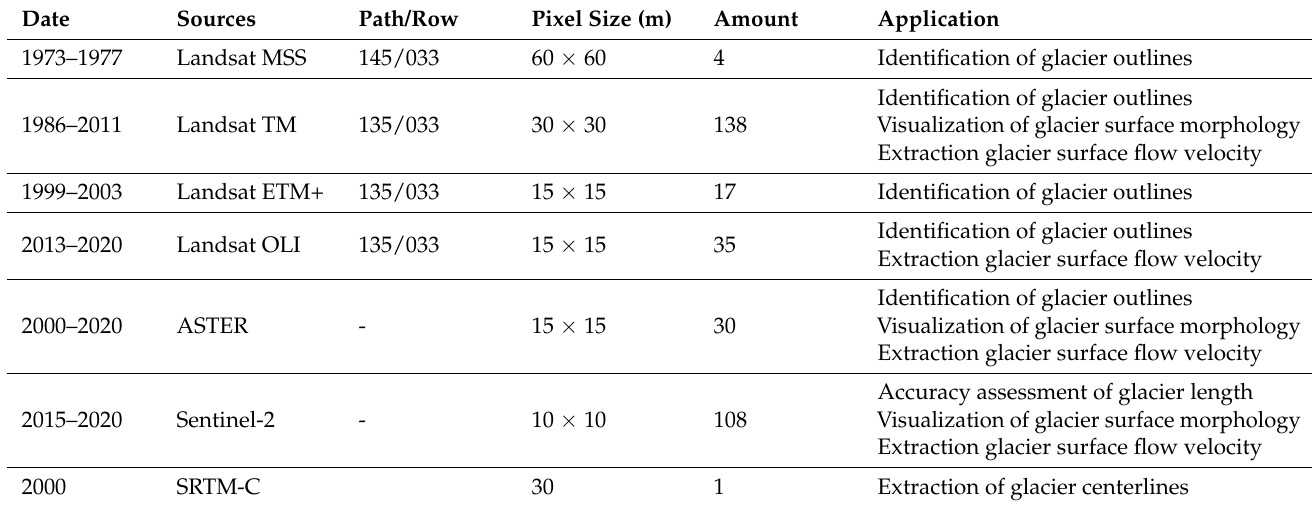
Table 1. Optical remote sensing images were used in this